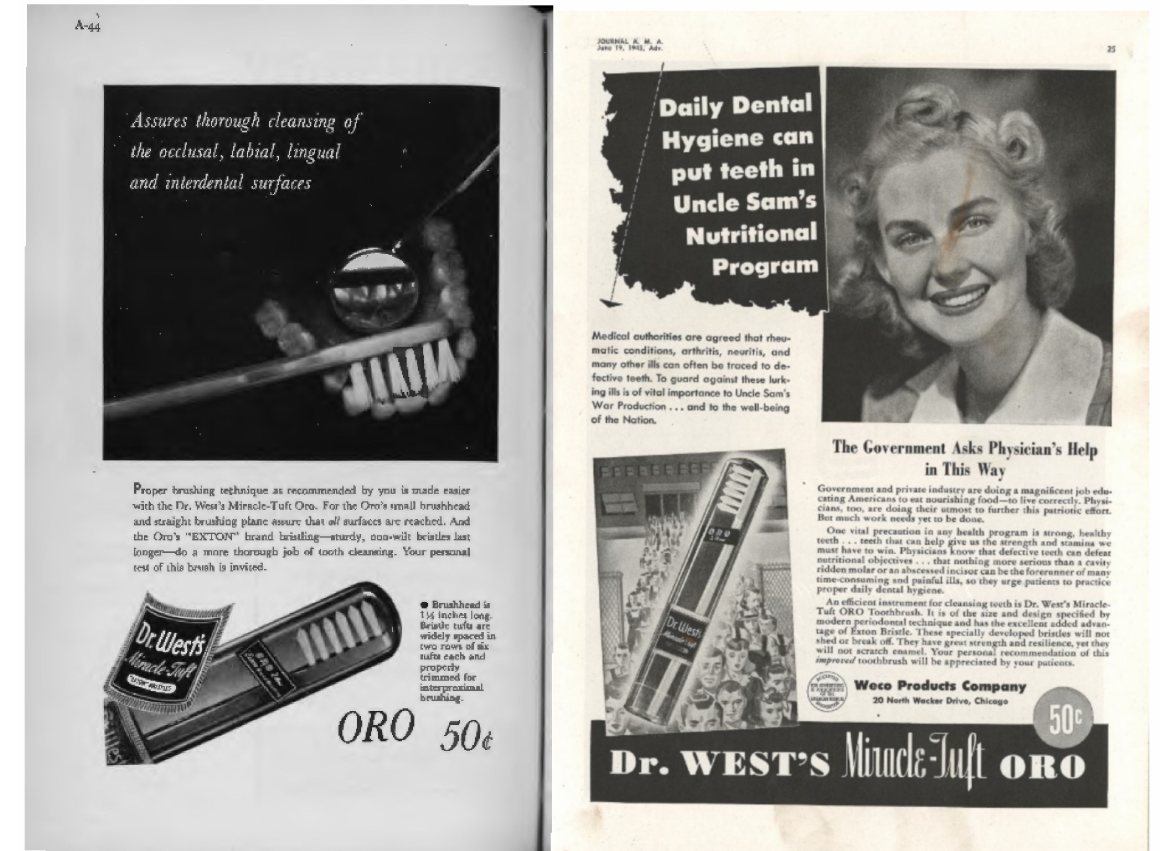
Figure 2. Advertisements for the first nylon-tufted toothbrush in JADA ( left ) [102] and JAMA ( right ) [103]. The ADA allowed toothbrushes to be advertised as cosmetic tools; the AMA authorized toothbrushes to be advertised as public health instruments. These differences in allowable advertising claims created an ADA-AMA